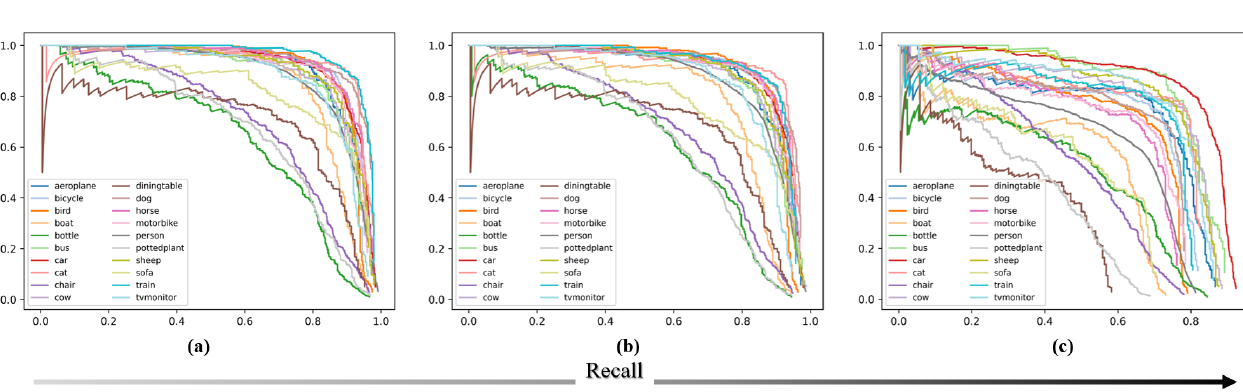
Figure 8. Precision–recall curve. ( a ) IoU threshold of 50%, ( b ) IoU threshold of 75%, and ( c ) IoU threshold of